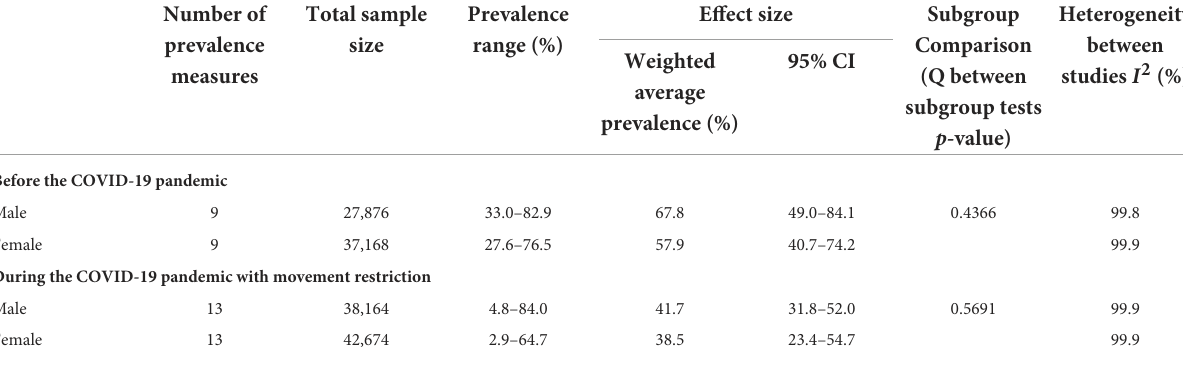
TABLE 2 Sex differences in physical activity prevalence before and during the COVID-19 pandemic in the adult general